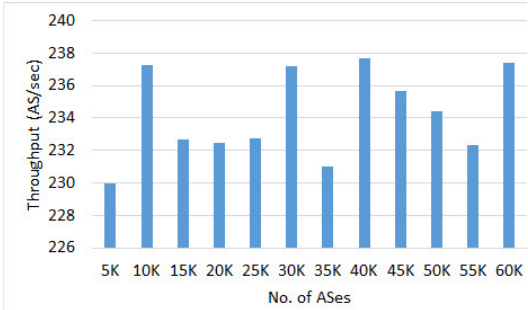
Figure 14. Average